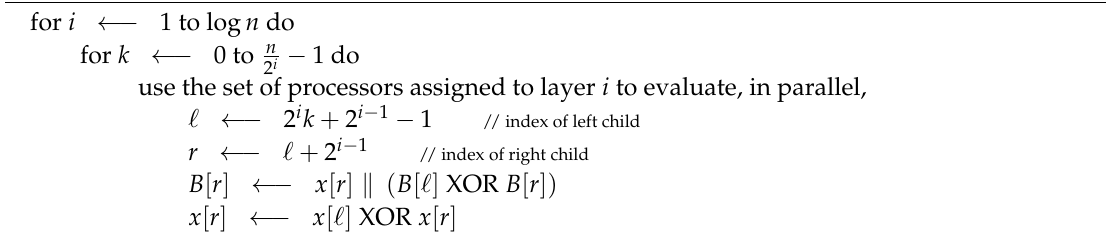
Algorithm 1 Hierarchical Parallel Evaluation of a Hamming Code